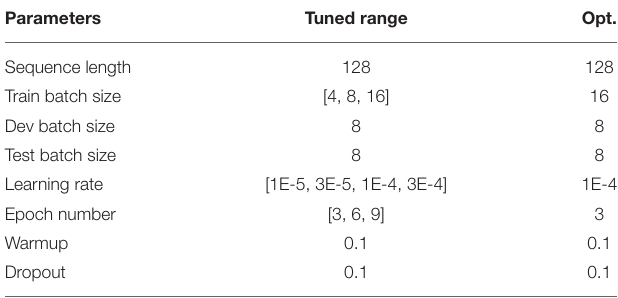
TABLE 4 | Hyperparameter setting for RoBERTa.